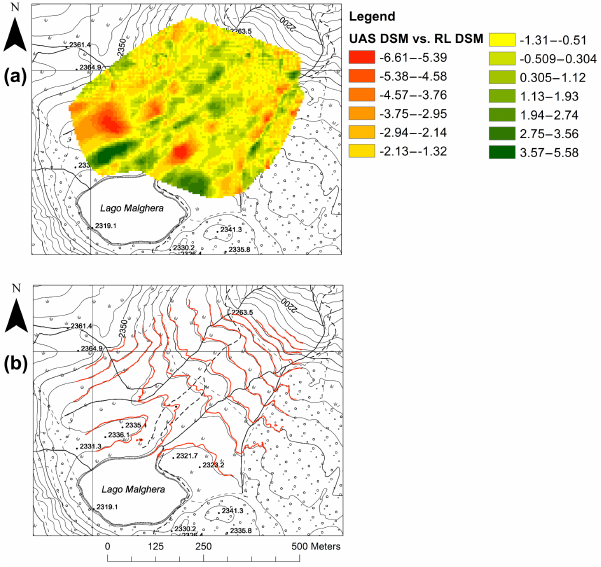
Figure 6. Validation of the DSM of bare soil (September 2013). (a) Map of the differences between the UAS-based DSM and an existing DSM provided by the Lombardy Regional Authority (5m cell size, differences in m). (b) Comparison between UAS-based contours (10m, in red) and those reported in the topographic map of the area (in black).